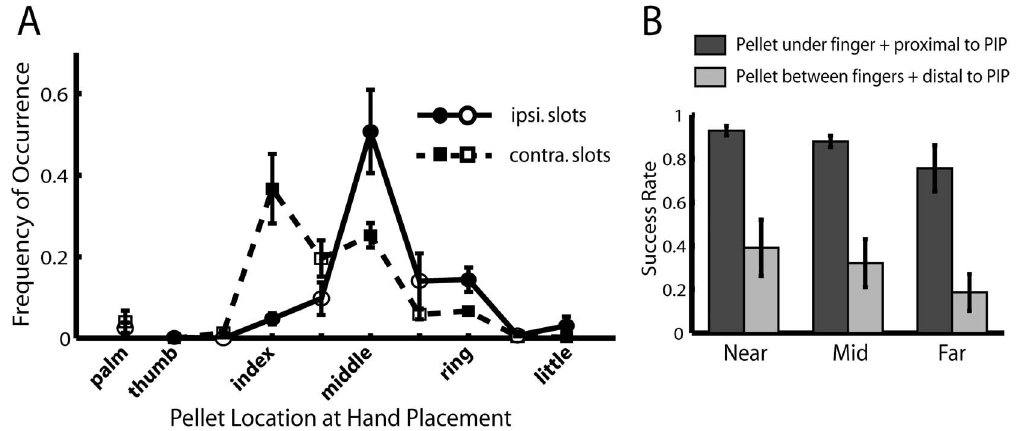
Figure 4. Successful pellet retrieval demanded strategic hand placement. A , The frequency of use of different digits in successful trials for ipsilateral and contralateral slots. In the successful trials, immediately before grasping, each rat positioned its paw so that the pellet was directly under one of the digits, in between two adjacent digits, or under the palm of the hand. The graph shows the frequency of occurrence for the above possibilities (filled symbols: under a digit; unfilled symbols: between digits or under palm) within the successful trials for the ipsilateral (circles connected by solid line) and contralateral (squares connected by dotted line) slots (mean 6 SEM), across the animals in the 12-day-Reach group (average over Day 1, 5, and 12). The two distributions were clearly separated with different means (Slot 6 Digit interaction, F(9,60)=6.8, p , 0.01) with the ipsilateral distribution peaking at the middle finger, and the contralateral, at the index finger. This suggests that grasping from these two different sets of slots involve the use of different digit sets. B , Strategies employed for slots at different distances from the rat. We calculated the rate of successful retrieval when, at the time of maximal forelimb extension, the pellet was directly under a finger (instead of between fingers) and was proximal in position to the PIP joint (dark grey bars), and when neither of these strategies was employed (light grey bars), over the near, mid, and far slots, respectively (mean 6 SEM). For all three slot sets, the success rate when the strategies were employed was clearly higher than when neither was employed (p ,